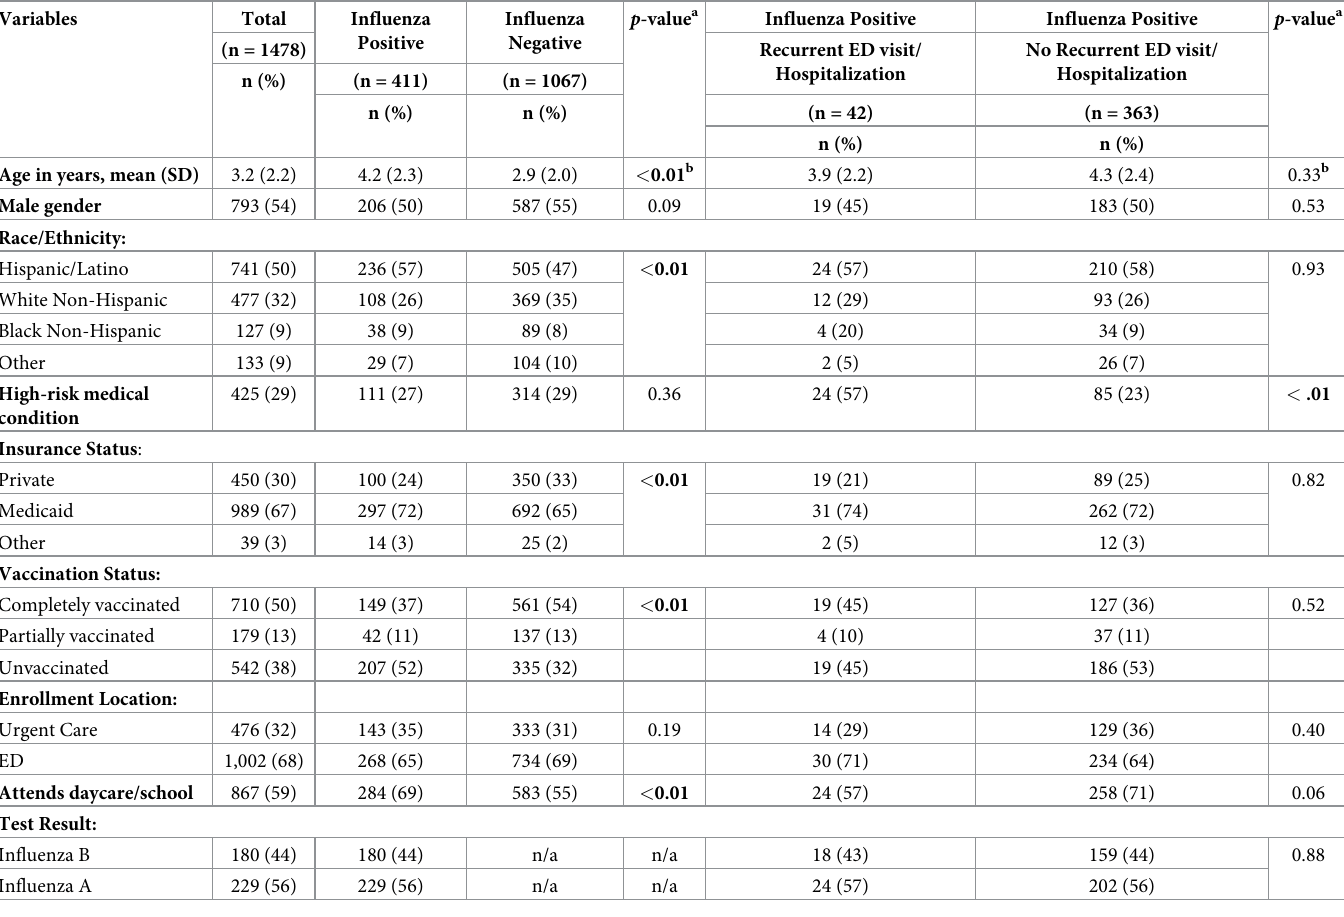
Table 1. Sociodemographic characteristics of study